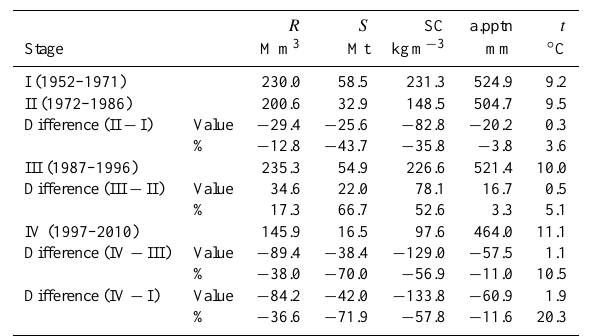
Table 2. Mean characteristics of each stage as identified by mass curve anomalies of normalized runoff ( R ), sediment load ( S ) and sediment concentration (SC).